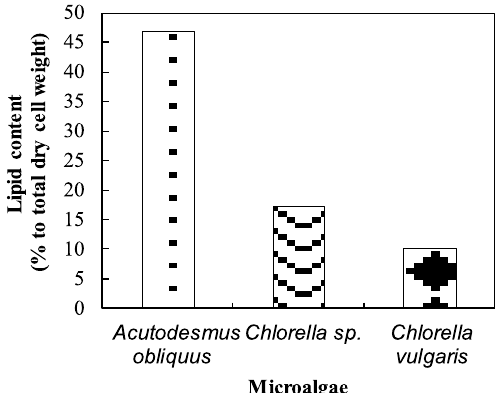
Fig. 4. Lipid content of Acutodesmus obliquus CN01 (percentage to total dry cell weight). Dotted bar: Acutodesmus obliquus CN01, wavy line bar: Chlorella sp. Carolina-15-2069, solid diamond: Chlorella vulgaris